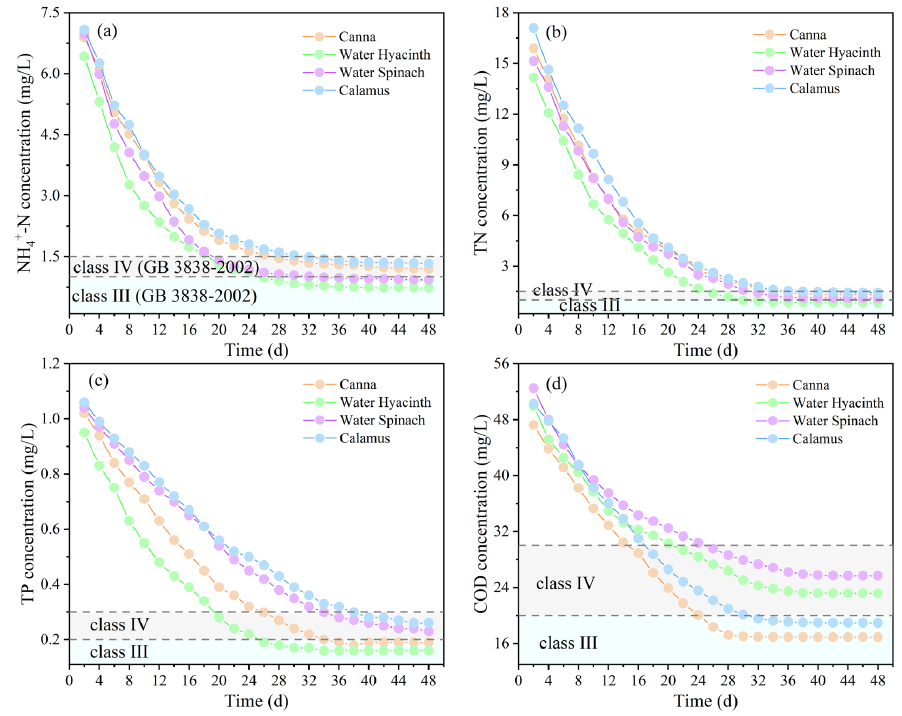
Figure 2. Removal enhancement via combining with biochar: ( a ) NH 4+ -N, ( b ) TN, ( c ) TP, ( d ) COD .